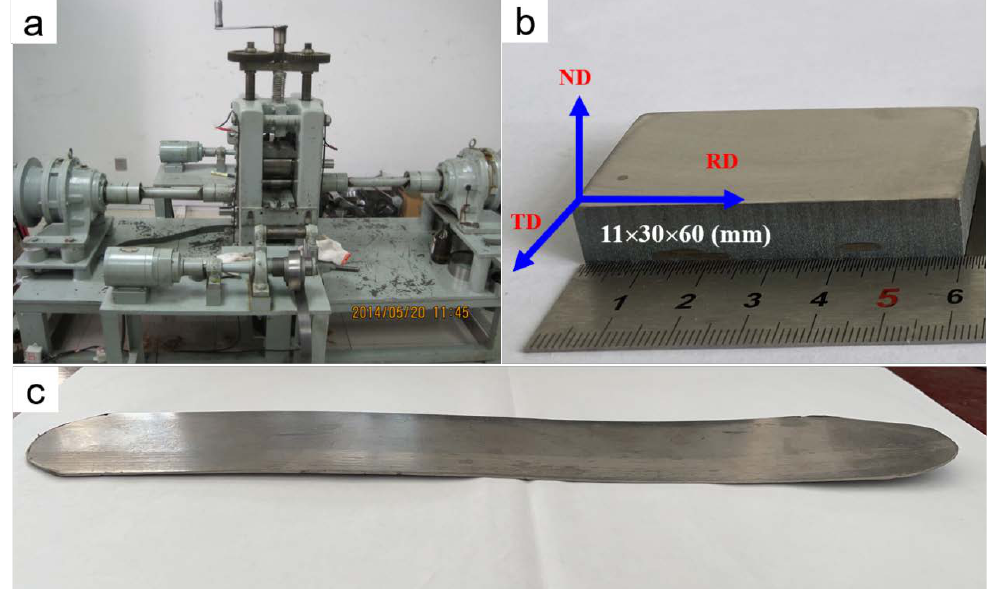
Figure 1. Micro-rolling mill and thin strip samples. ( a ) Experimental setup; ( b ) raw material of high purity; ( c ) a thin strip with a thickness of 0.86 mm.